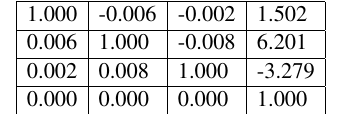
Table 4. Transformation matrix to correct the TIR point cloud after ICP is calculated.